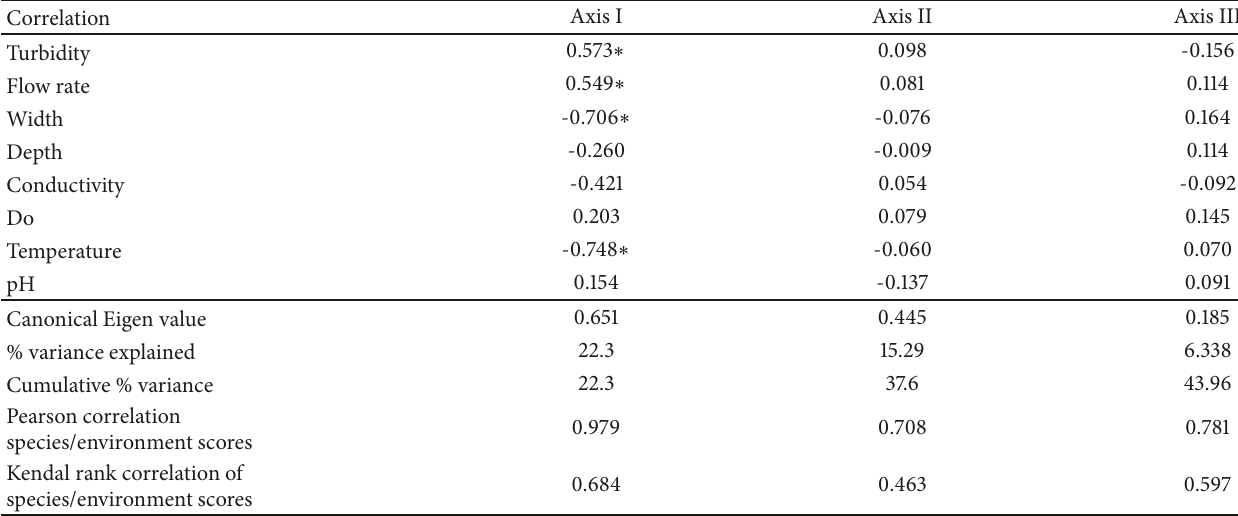
Figure 2: Broken stick model for Odonata rank abundance distribution across the three water types in Ankasa Conservation Area. Abundance is based on cumulative values per species test sites. Notice that SADs are ordered in decreasing magnitude and plotted against the corresponding rank order. Table 3: Canonical coefficients and the correlations with the first three axes of the environmental variables of the canonical correspondence analysis (CCA) for the three water types. Interset correlations were significant ( p < 0.05 ∗ ) for the three